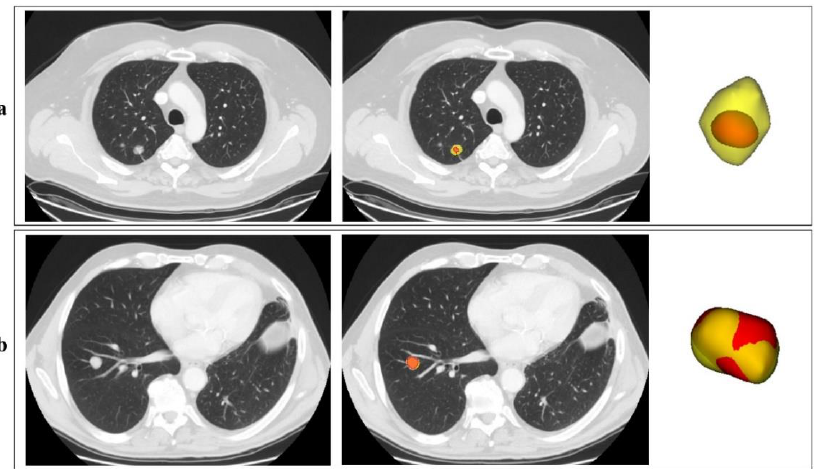
Figure 3. Examples of the automatic segmentation outputs. In the picture, two outputs of the seg- mentation network, corresponding to two different patients ( a , b ), are reported in red, superimposed onto the manual segmentation in yellow. For each patient, one axial CT slice including the lesion is reported, without ( left ) and with ( right ) indication of the lesion contours; the 3D visual representation of the contours is also reported. Although the two lesions are quite similar in shape and volume, the lesion for patient in Figure 3a is characterised by a low-density edge which is not captured by the automatic algorithm.